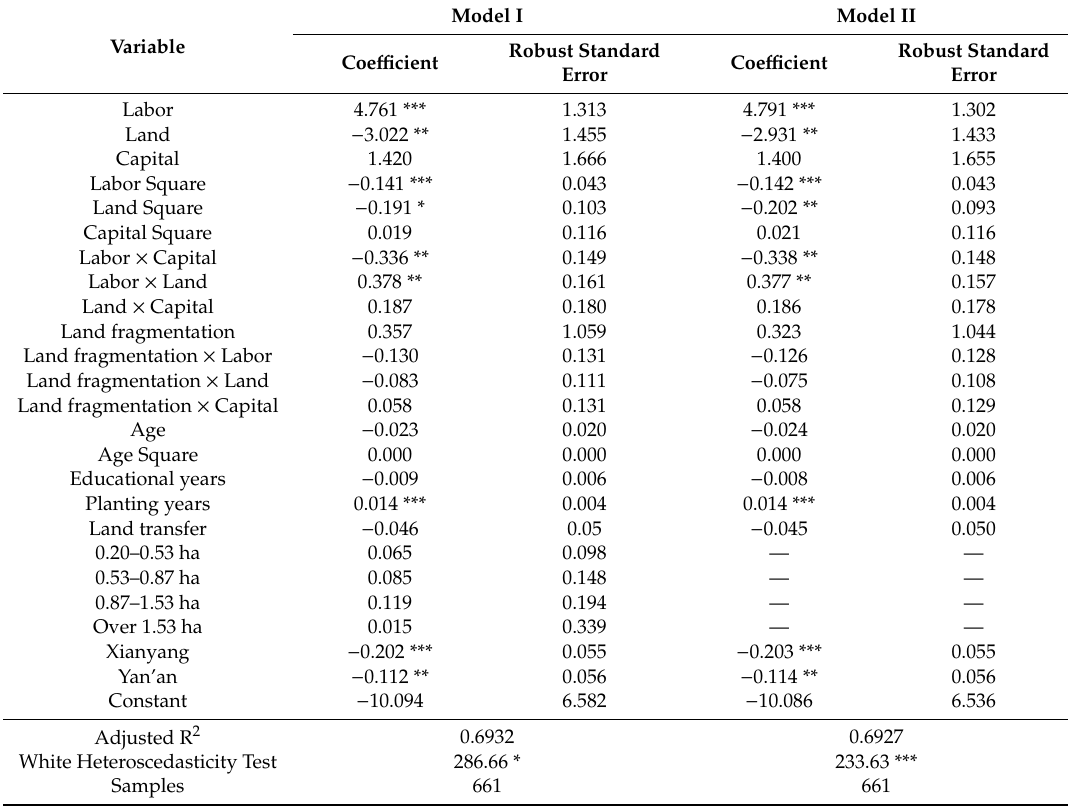
Table 3. Results of the input–output model.